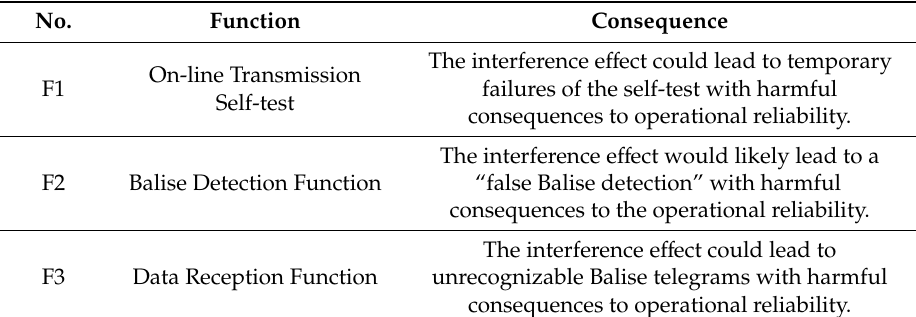
Table 1. The functions of BTM (Balise Transmission Module) system.